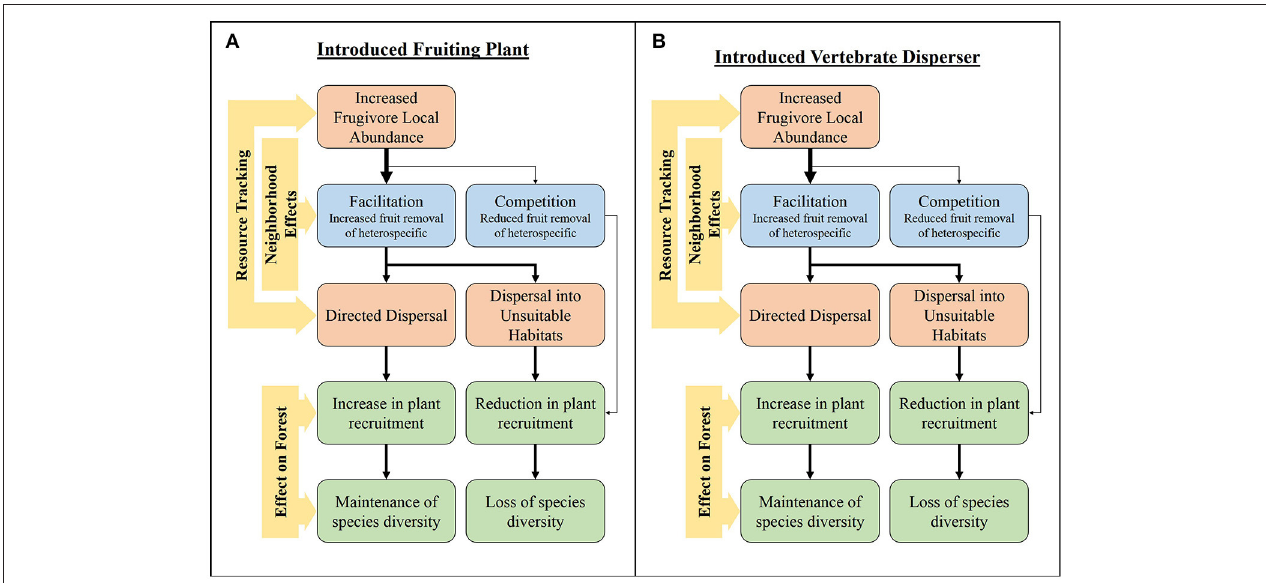
FIGURE 2 | The influence of resource tracking on the fruit removal and potential seed dispersal through different types of neighborhood effects with the introduction of (A) a fruiting plant and (B) a frugivore.